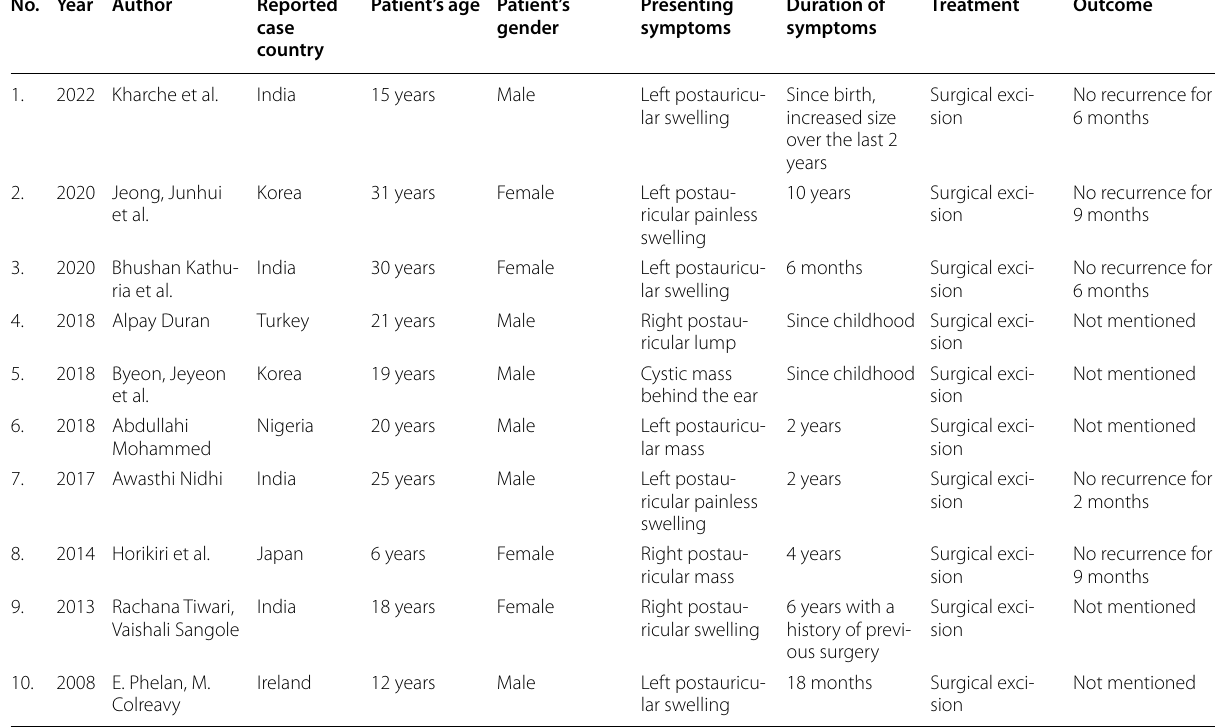
Table 1 Summary of the most recently reported cases of postauricular dermoid